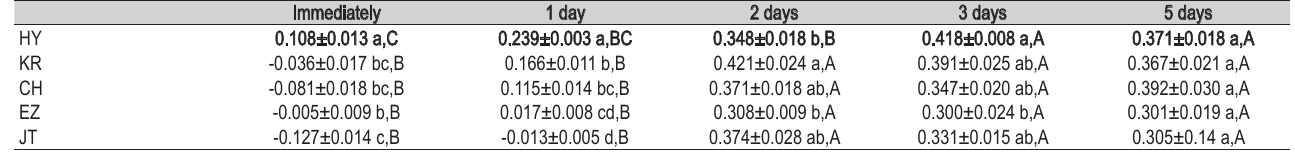
Table 1 - Mean of dimensional alteration and SD (%) of stone casts obtained with different alginates and poured in different periods of time (distance 37-47).